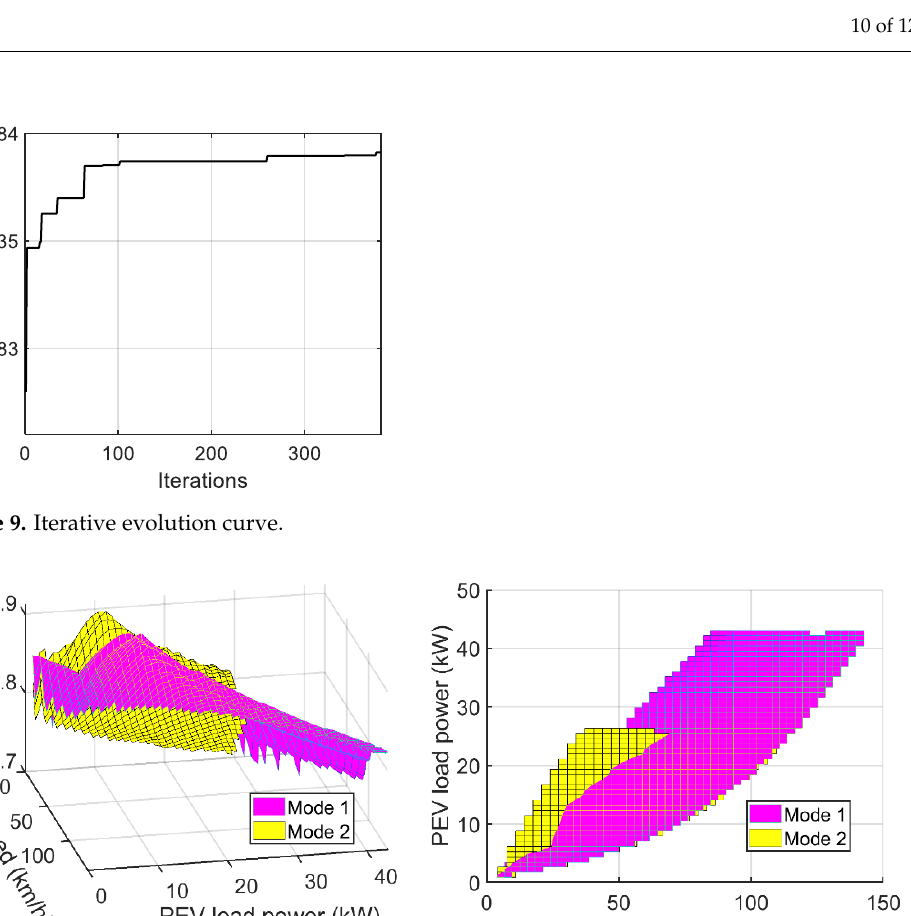
Table 3. Results comparison.